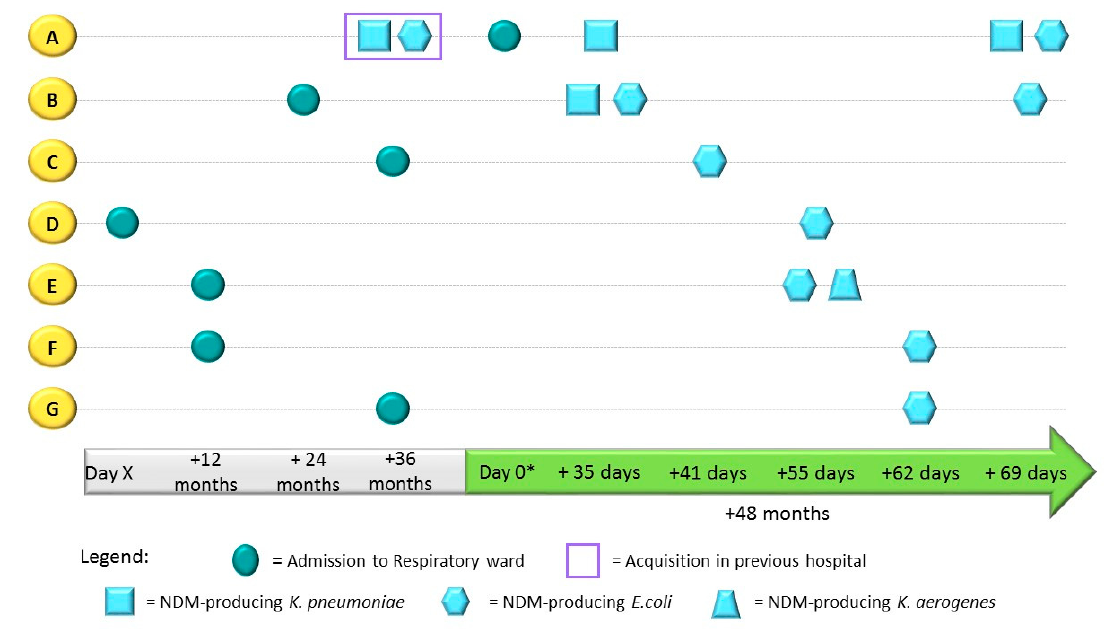
Figure 3. Epidemiological timeline of Case Study 3: patients A–G’s admission to hospital ward, CPE acquisition, and screening results spanning 5-year period. * From day 0 (start of outbreak), all patients were screened for CPE on a weekly basis, until receipt of a positive sample. Table 3. Summary of results of CPE-positive bacteria isolated during CPE screening in Case Study